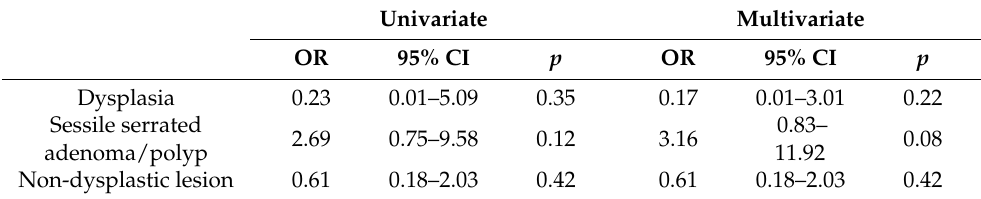
Table 3. Univariate and multivariate logistic regression for lesions missed by